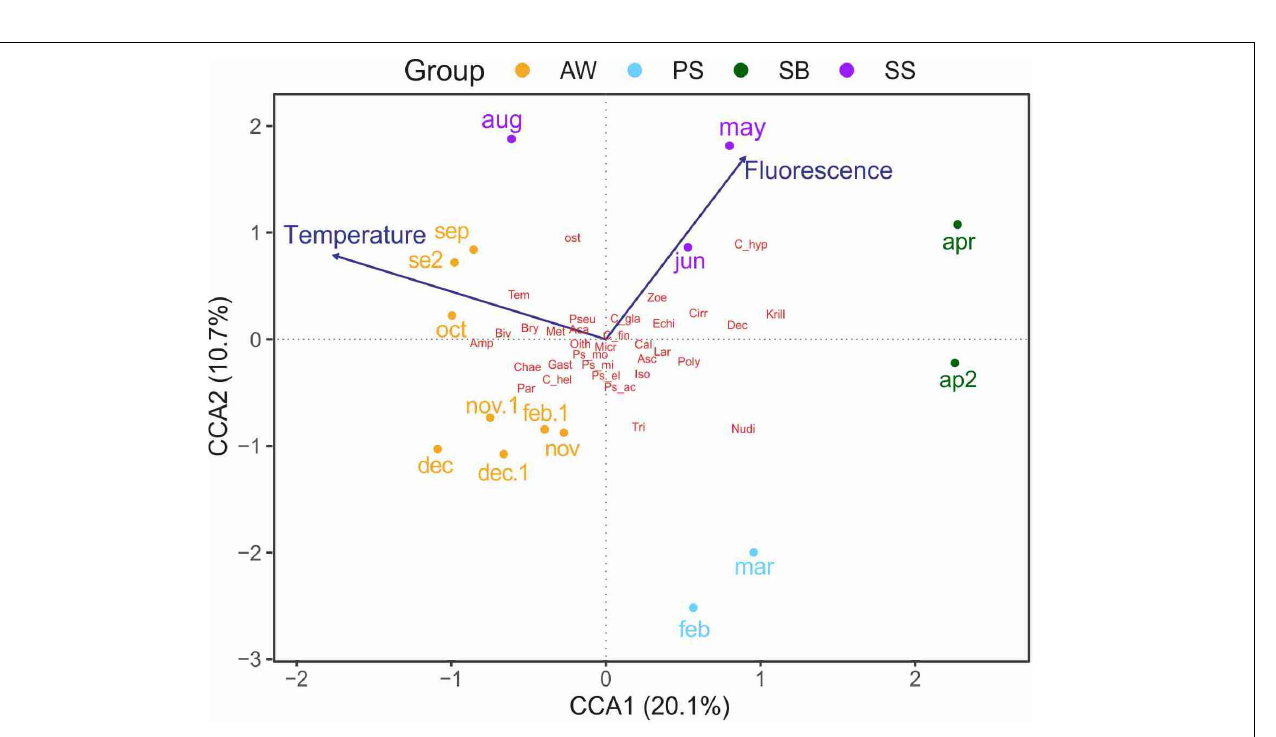
FIGURE 7 | Canonical correspondence analysis (CCA) of fourth-root transformed abundance data. The eigenvalues as percentages are provided for dimensions I and II with a total of 30.8% and variance explained. Colors correspond to the assemblages obtained by the hierarchical cluster analysis ( Supplementary Figure 1 ). The abbreviations used in this analysis are explained in Table 4